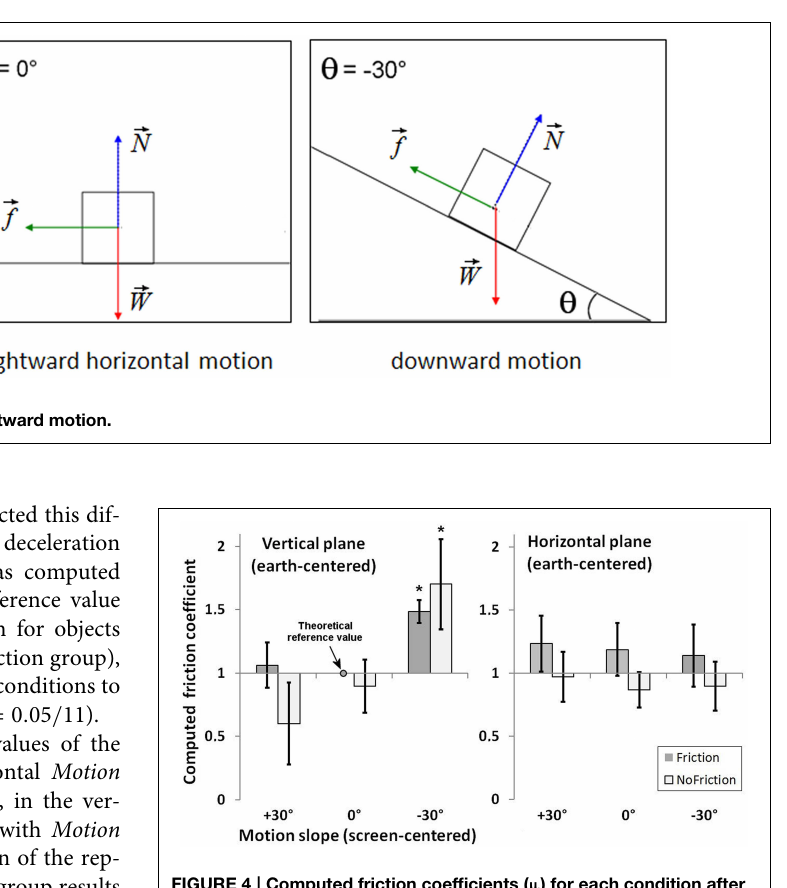
FIGURE 4 | Computed friction coefficients ( µ ) for each condition after setting the theoretical reference value to µ = 1 in the vertical Motion plane condition for objects traveling along a 0 ◦ Motion slope visible surface. Stars indicate significant departure from the theoretical value after Bonferroni